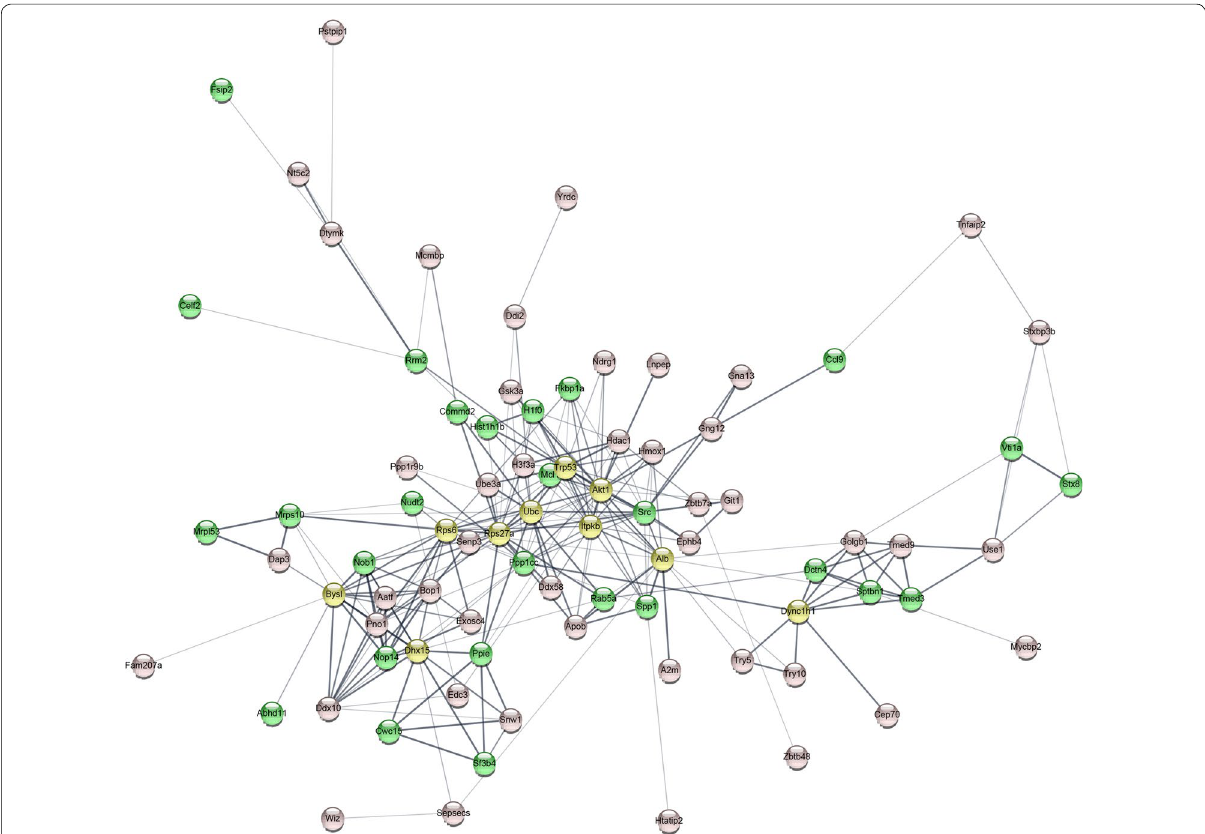
Fig. 4 The protein–protein interaction network of the differentially expressed proteins were analysed by STRING and presented with Cytoscape software. Pink bubbles represented upregulated proteins, green bubbles indicated downregulated proteins, yellow ones were related proteins while not identified as differential abundance